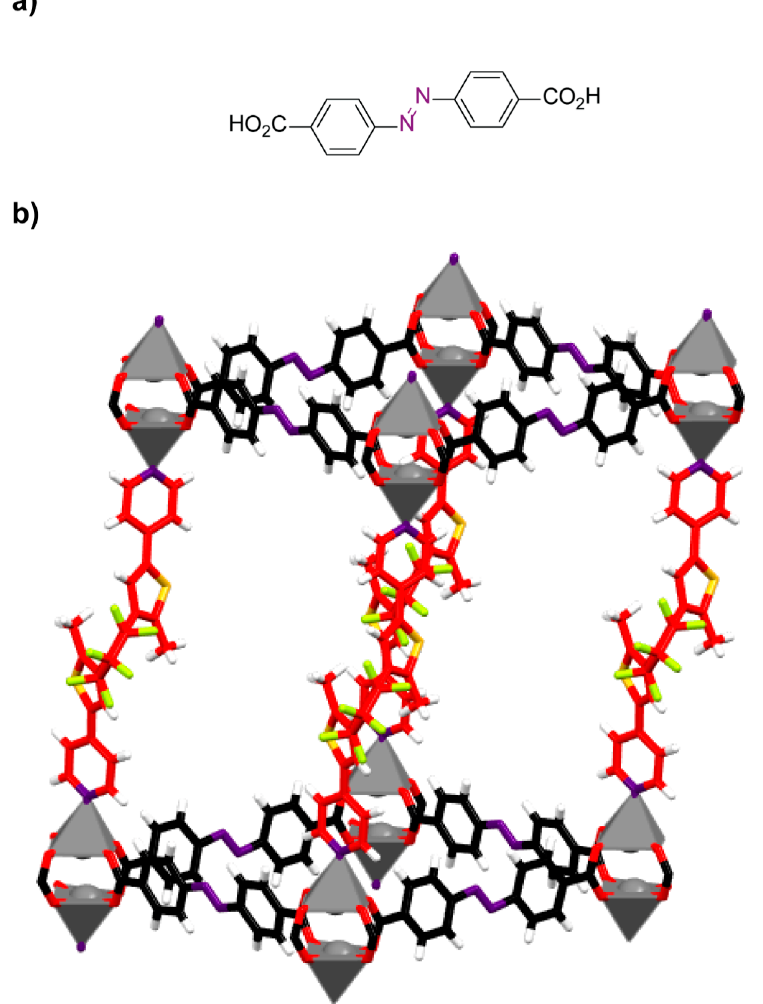
Figure 7. ( a ) Chemical structure of azobenzene 4 ; ( b ) stick representation of the crystal structure of ECUT-30 showing a portion of the lattice framework [70]. Interpenetration is omitted for clarity in the solid structure. Color key: grey = zinc atoms; black = carbon atoms of the azobenzene ligand 4 ; red = oxygen atoms and carbon atoms of the diarylethene ligand 3 ; white = hydrogen atoms; yellow = sulfur atoms; green = fluor atoms; purple = nitrogen